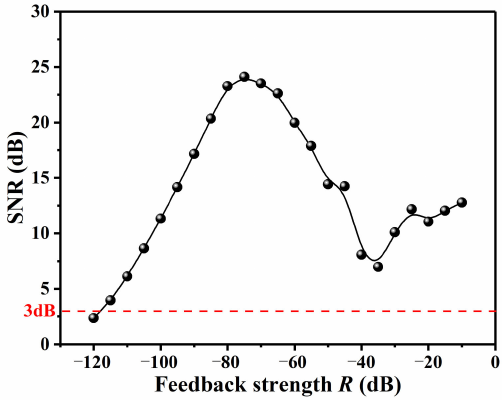
Figure 9. SNR versus feedback strength with optimized parameters, which are I b = 2 I th , α = 5, r 0 = 0.33, 200 µ m internal cavity length, ∆ F = 4.68 GHz, and ∆ f = 0.1 F , respectively.